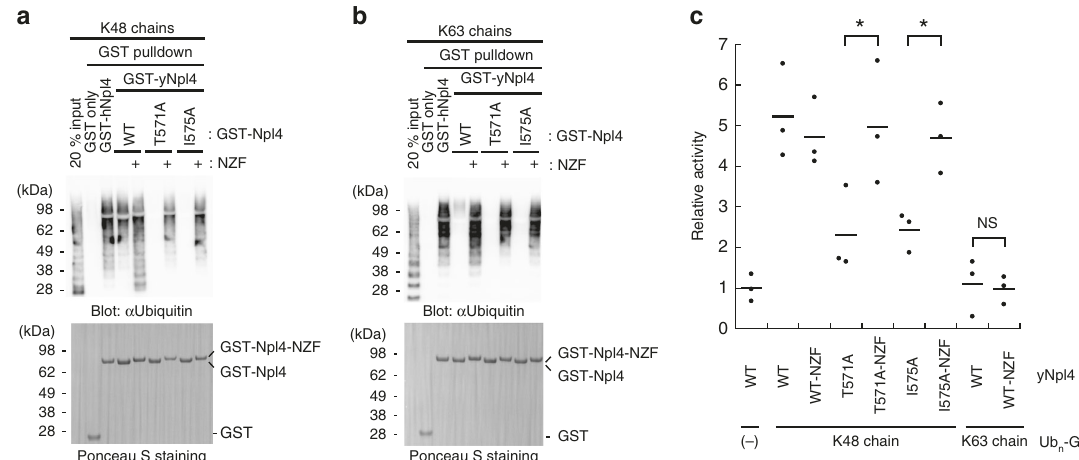
Fig. 4 Analysis of the NZF-fused yNpl4. a , b Analysis of the binding of GST-hNpl4, GST-yNpl4 or GST-yNpl4-NZF to K48 chains ( a ) or K63 chains ( b ) by pulldown assays. The bound Ub chains were detected by immunoblotting with anti-Ub antibody (upper panel). Blot membranes were stained with Ponceau S (lower panel). 20% input means that 20% of the volume of the sample (Ub chains) that was mixed with GST-yNpl4- or GST-yNpl4-NZF-bound glutathione resin. These experiments were repeated with distinct samples (Supplementary Fig. 6c). Source data are provided as a Source Data fi le. c ATP hydrolysis rates of the Cdc48 – UN complex containing yNpl4 or yNpl4-NZF with K48-Ub n -GFP or K63-Ub n -GFP. The rates were normalized to the average of the ATP hydrolysis rates of the wild-type Cdc48-UN complex without Ub n -GFP. The line represents the mean of the rates after normalization (mean values; n = 3 independent experiments; * P < 0.05 from Student's t